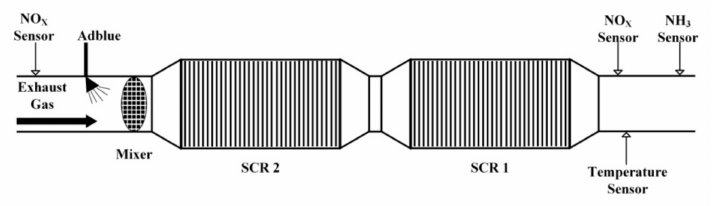
Figure 2. Two-cell SCR catalyst